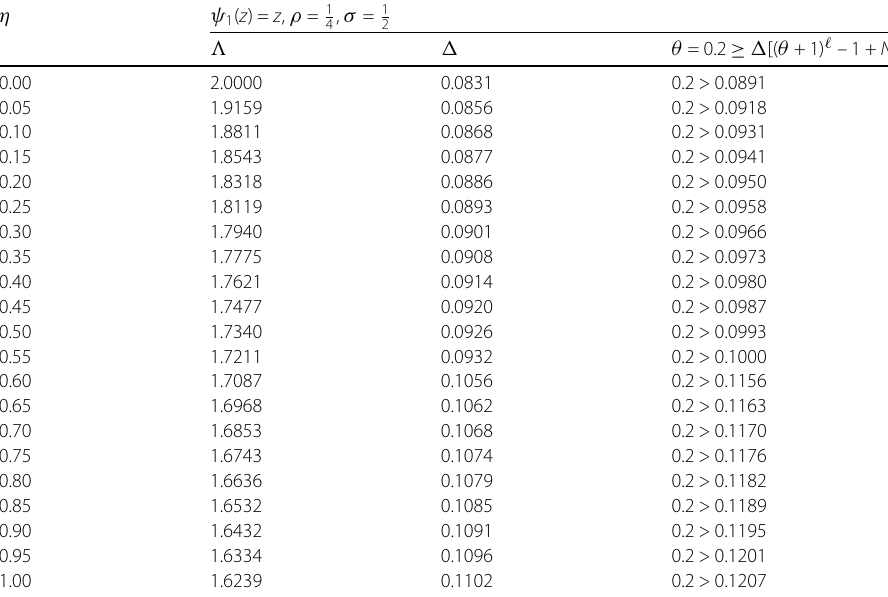
Table 1 Numerical results of (cid:27) and θ for ψ 1 ( z ) = z and η ∈ J = [0,1] in Example 5.1 η 0.00